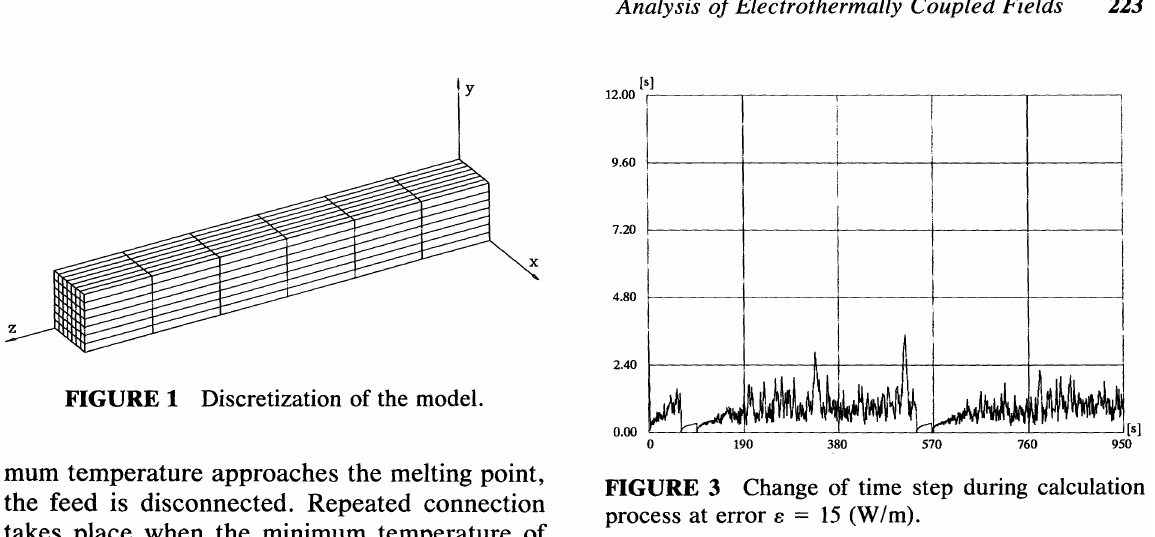
FIGURE 3 Change of time step during calculation process at error e = 15 (W/m).